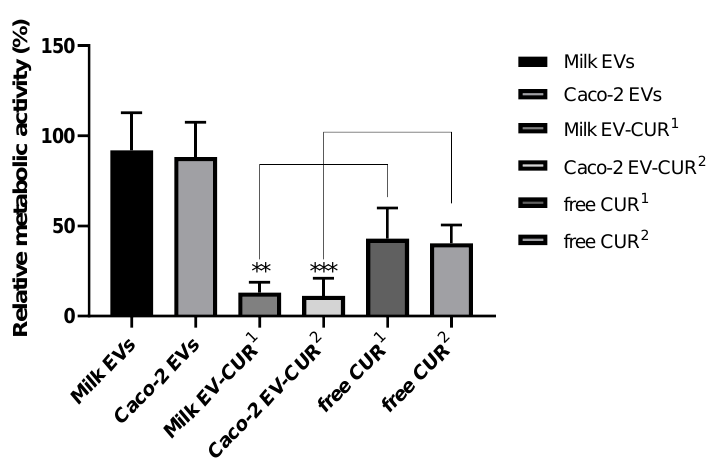
Figure 3. Antiproliferative activity of extracellular vesicle-incorporated curcumin (EV-CUR) and free curcumin (CUR) in Caco-2 cells. Triton X-100 (0.1% v/v ) and exosome-depleted culture medium were used as controls relative to which metabolic activity of samples was calculated. Cells were treated with milk EV-CUR 1 (4.5 µg/ml), free CUR 1 (4.5 µg/ml), Caco-2 EV-CUR 2 (1.5 µg/ml), free CUR 2 (1.5 µg/ml). Data shown as the mean +/- SD (n=6). ** and *** denotes p < 0.005 and p < 0.001, respectively.